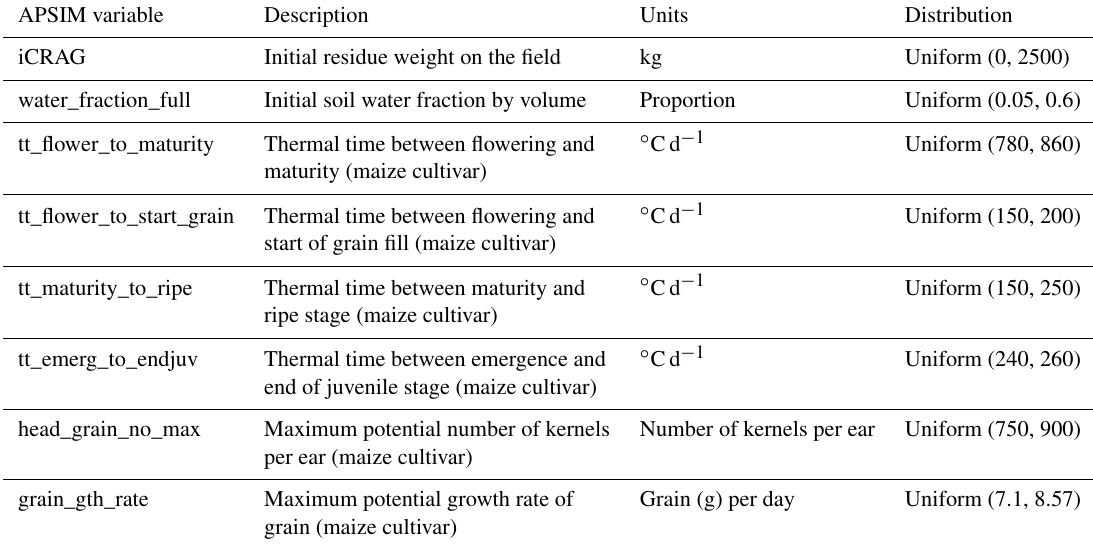
Table A2. Prior distributions for model